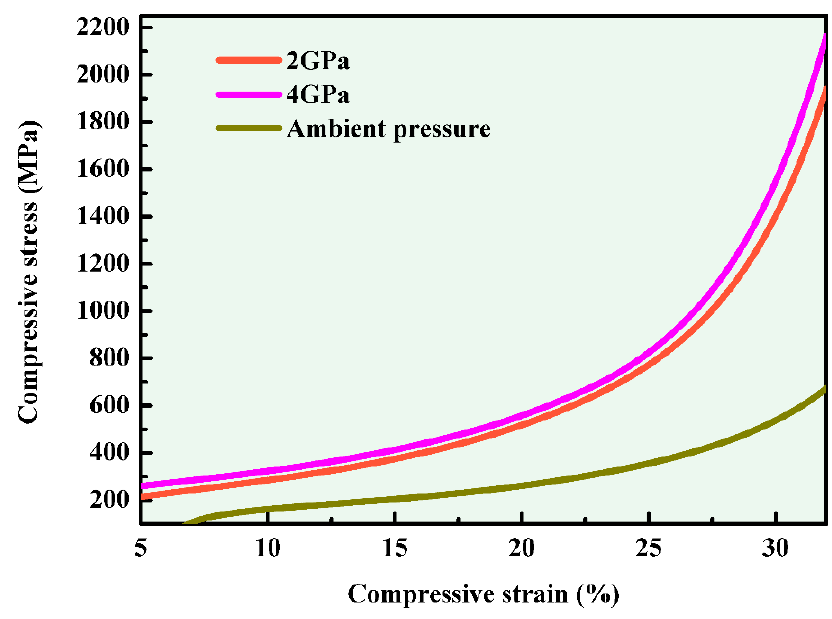
Figure 5. Compressive stress–strain curves of Al-5.4Ni-2Sn alloy at different pressures.